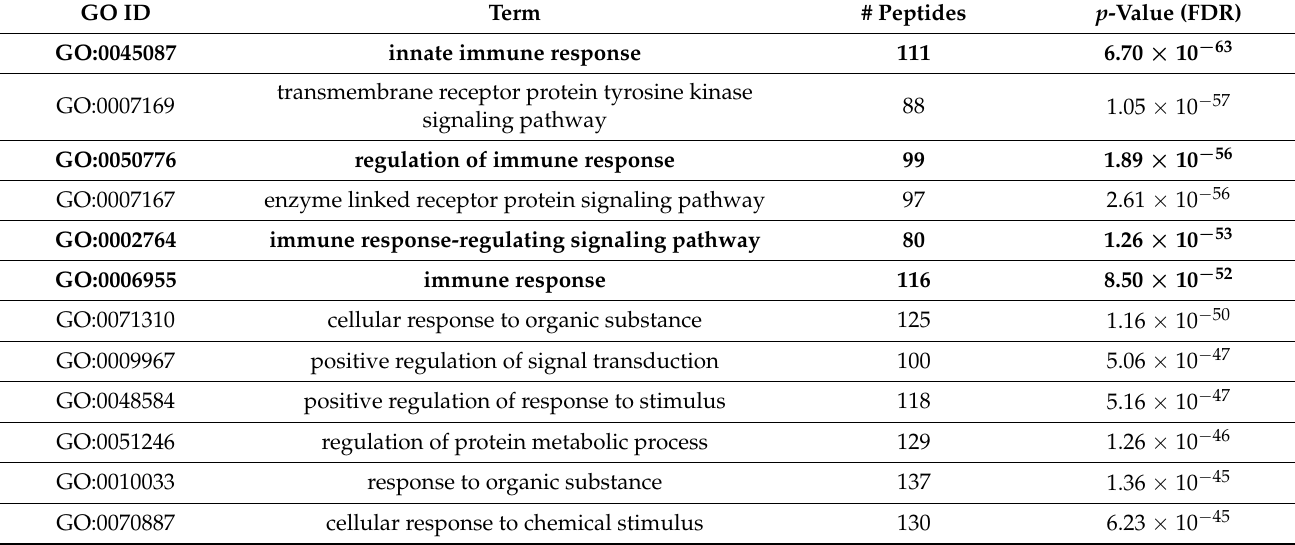
Table 9. Top 12 GO biological processes in the sub-iliac lymph nodes collected from feedlot cattle in the summer and winter months. A list of representative GO terms was generated by taking the statistically significant peptides from the comparison and inputting this peptide list into the online STRING database. Presented below are the top 12 terms from the input data. The pathways in bold are those involved in the immune response (total immune peptides 406).